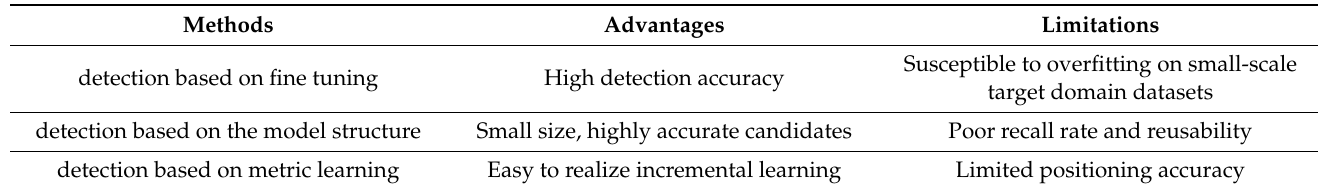
Table 1. Advantages and limitations of the main few-shot object detection